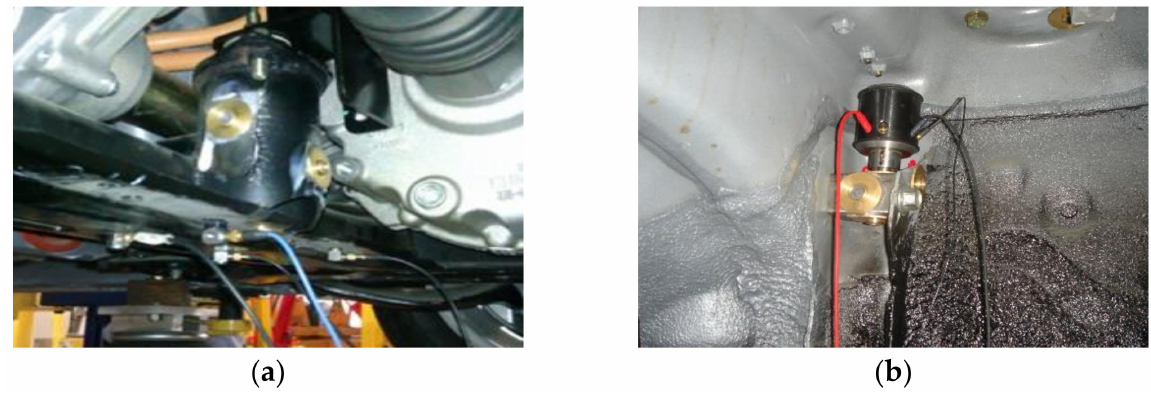
Figure 9. Positions for measuring the transfer path functions of the mount and suspension: Layouts of ( a ) the acceleration sensor at the mount and ( b ) the exciter at the